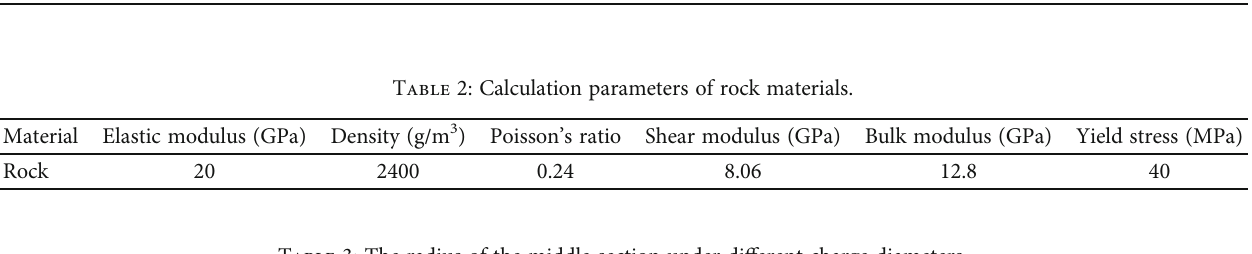
Table 3: The radius of the middle section under di ff erent charge diameters.